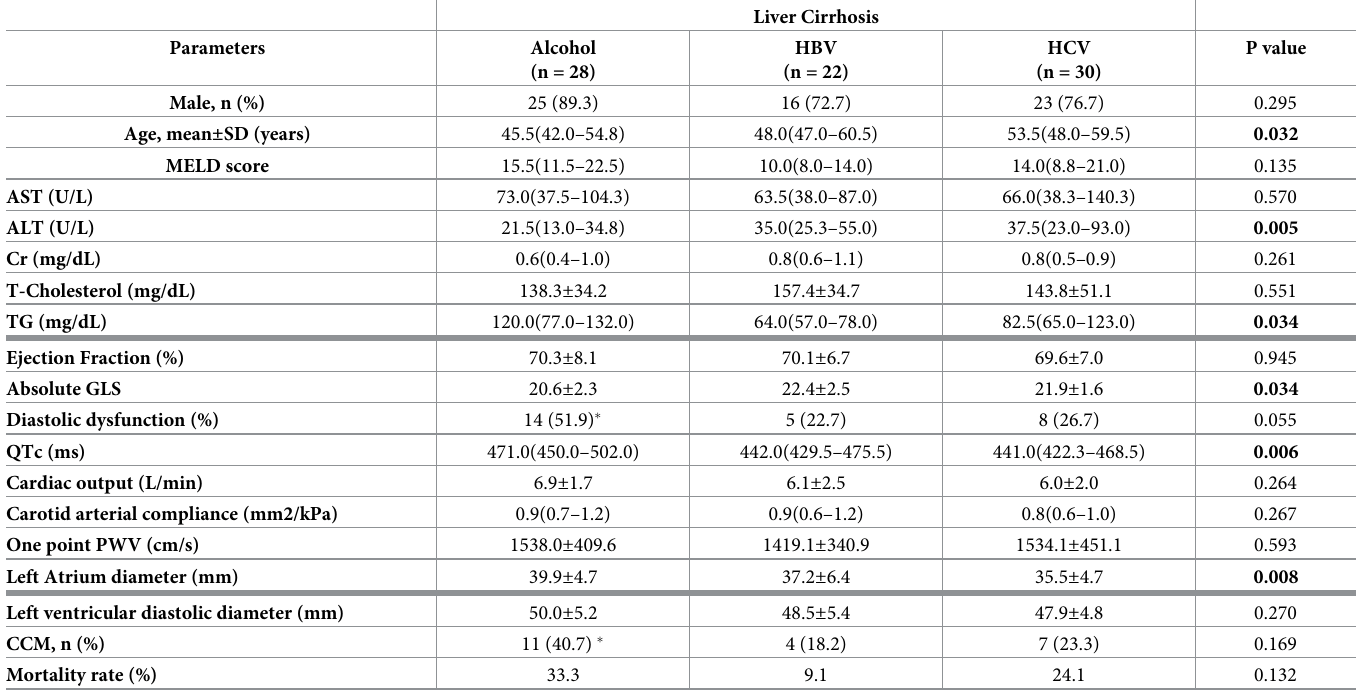
Table 2. Demographic characteristics of control group and different etiologies of liver